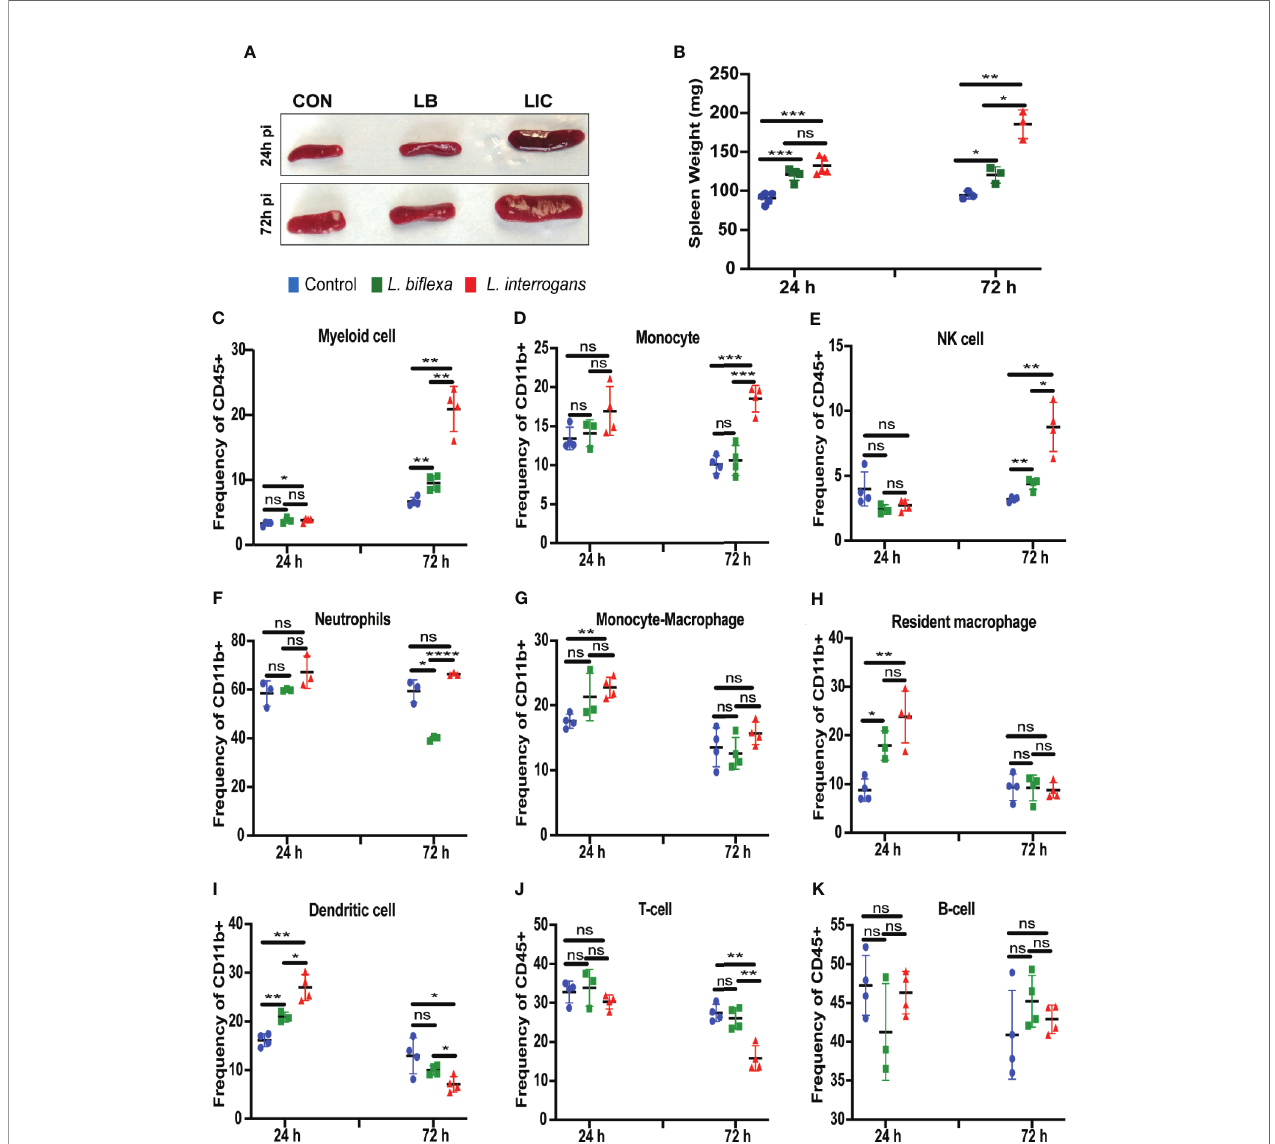
FIGURE 5 | Spleen morphometry and fl ow cytometric analysis of immune cells after infection. (A) depicts clear L. interrogans induced splenomegaly, while L. bi fl exa spleen appears to retain normal splenic architecture as do controls at 24h and 72h pi. (B) is the representation of respective splenic weight in milligrams, differences in weight were measured both for L. bi fl exa and L. interrogans . Statistical analysis between groups was done by unpaired t-test with Welch ’ s correction, *p<0.05, **p<0.01, ***p<0.001, n= 3-5 mice per group. (C – K) represent different immune cell population in spleen at 24h and 72h pi. Myeloid cells like monocytes (D) , neutrophils (F) , monocyte-macrophage (G) , resident macrophage (H) , and dendritic cells (I) were determined based on CD11b+ frequency. Myeloid cells (C) , NK-cell (E) , T-cell (J) and B-cell (K) were measured in terms of CD45+ frequency. Statistical analysis was done by unpaired t-test with Welch ’ s correction between control and infected groups, where *p<0.05, **p<0.01, ***p<0.001, ****p<0.0001, ns, non-signi fi cance; n=4 mice per group. Data represents one of three independent